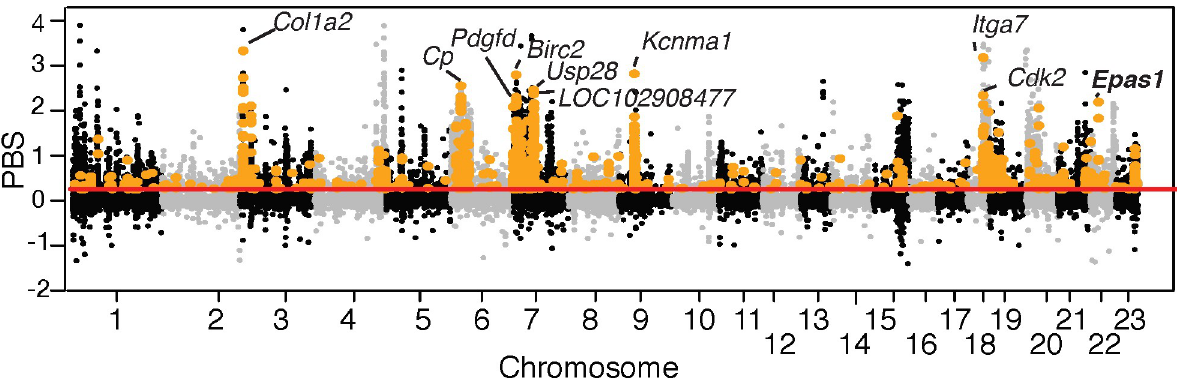
Fig 4. Epas1 is an outlier in a demographically-controlled selection scan. Exome-wide distribution of population branch statistic (PBS) for Mt. Evans mice based on 5,182,530 SNPs from the exome. Horizontal line (red) indicatesthe top 0.1% percentile PBS of 500,000 neutral SNPs simulated under a realistic demographic scenario, and SNPs in hypoxia-related genes are highlighted in orange. The top ten hypoxia-related genes are labeled, with Epas1 indicated in bold text. SNPs with a PBS value below the top 0.1% percentilehave been randomly down-sampled (1:20) for ease of plotting.